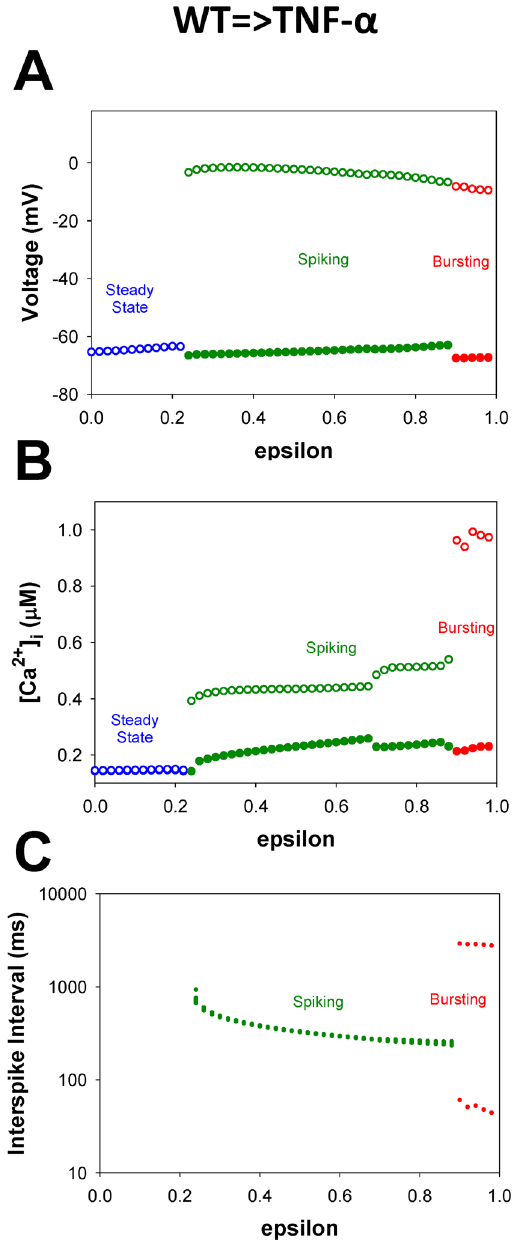
Figure 8. Simulated dependences of AP amplitudes (Panel A), [Ca 2 + ] i transients (Panel B), and interspike intervals (Panel C) for mouse ventricular myocytes on the parameter ε during transition from WT to TNF- α overexpressing mouse ventricular myocyte. Steady-state injected current I stim = 0.55 pA/pF. Bifurcation diagrams demonstrate steady-state, periodic activity, and bursting activity both for AP and [Ca 2 + ] i transients. AP amplitude, [Ca 2 + ] i transients, and interspike intervals were calculated in time interval from 40 to 50 s. For calculation of interspike intervals the threshold potential was set to V th = − 40 mV. I Na with slow